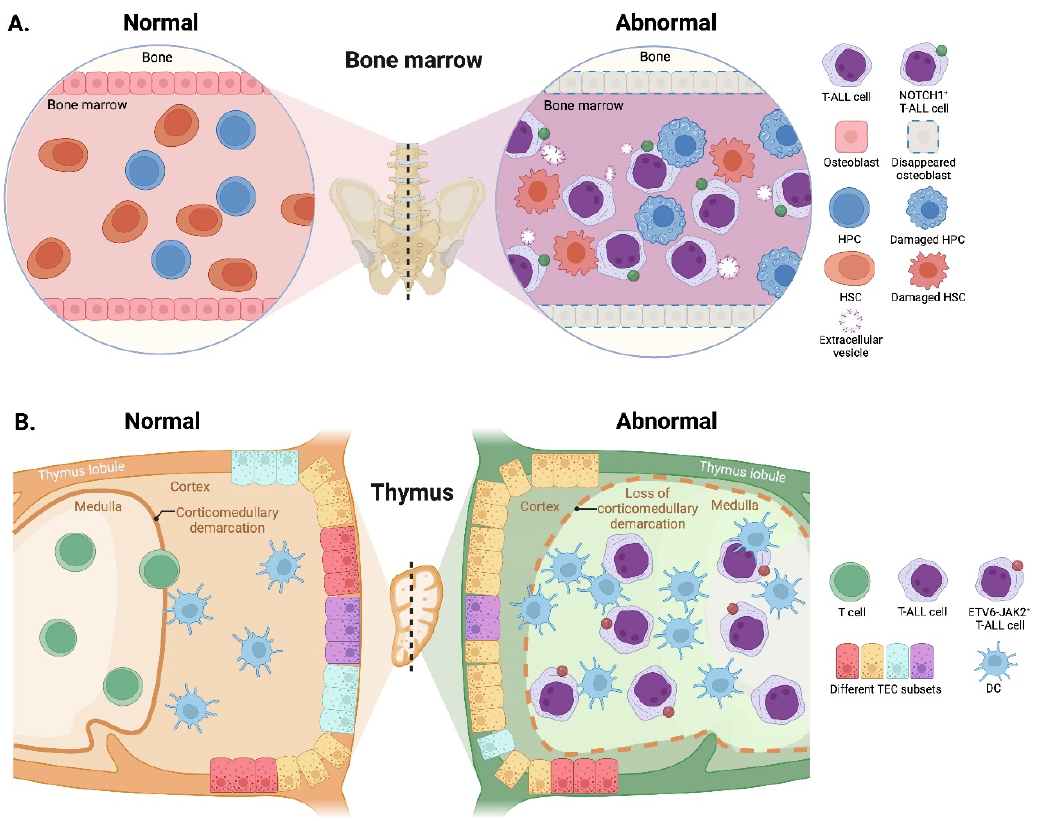
Figure 3. Reciprocal effects of T-ALL cells on microenvironments. ( A ) In the BM, accumulated T-ALL burden leads to a complete loss of osteoblasts and induces impairment of HSCs and HPCs. T-ALL-produced extracellular vesicles also disturb the quiescence and maintenance of HSCs and HPCs, thus, inducing exhaustion of the normal HSCs and HPCs. ( B ) In the thymus, the invasion of T-ALL cells impairs the normal corticomedullary demarcation accompanied by strong cortical reduction and medullary expansion. The proportions of TEC subsets and the number of DCs are also remarkably altered. HPCs, hematopoietic progenitor cells; HSCs, hematopoietic stem cells; TEC, thymic epithelial